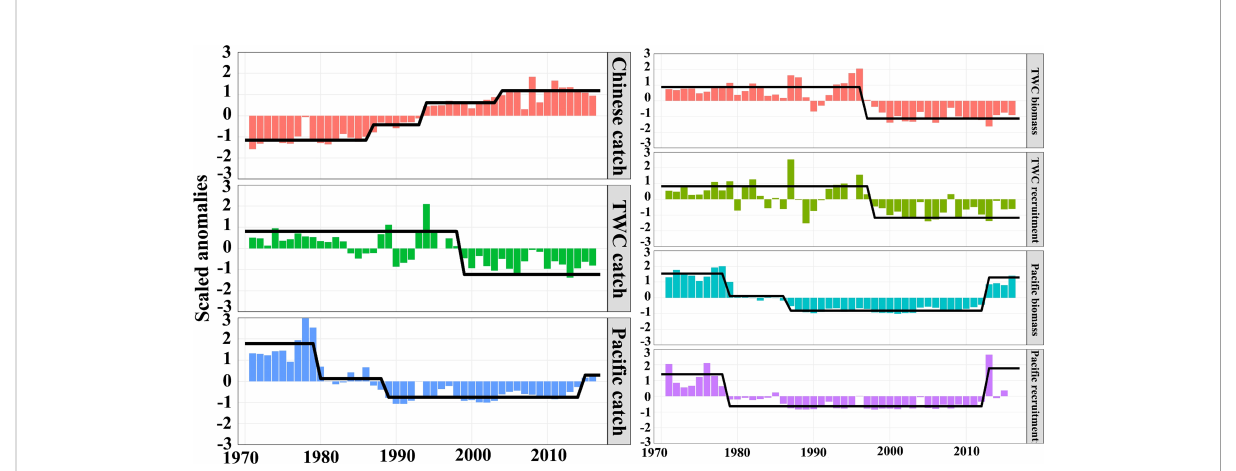
FIGURE 3 Left column shows the step changes of the catch (i.e., Chinese catch, TWC catch, and Paci fi c catch). The right column shows the step changes in biomass and recruitment. The bars indicate anomalies and the black lines represent regime means detected by the